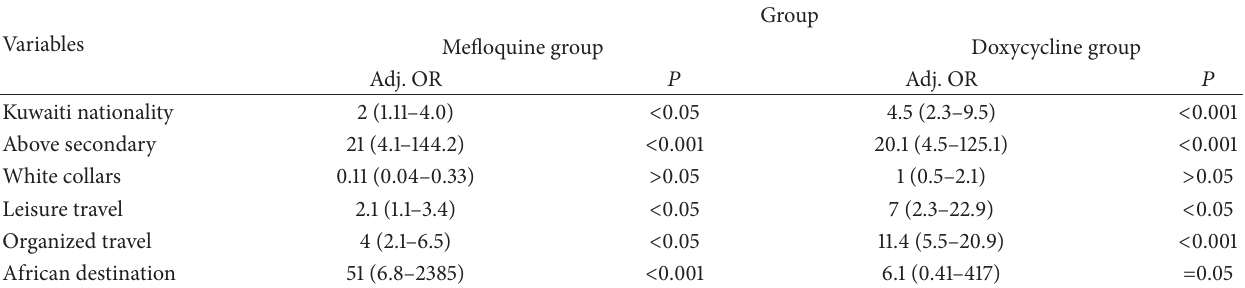
Table 5: Multivariate analysis of some risk factors in both